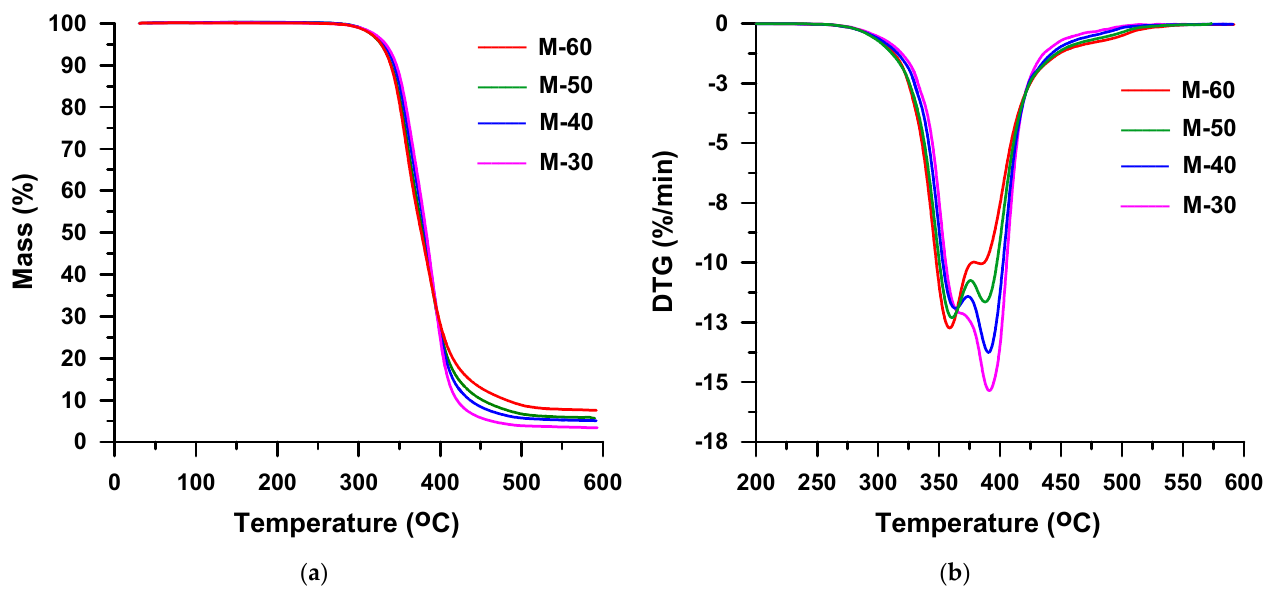
Figure 9. TG ( a ) and DTG ( b ) curves of the MDI-based TPU elastomers obtained in helium.